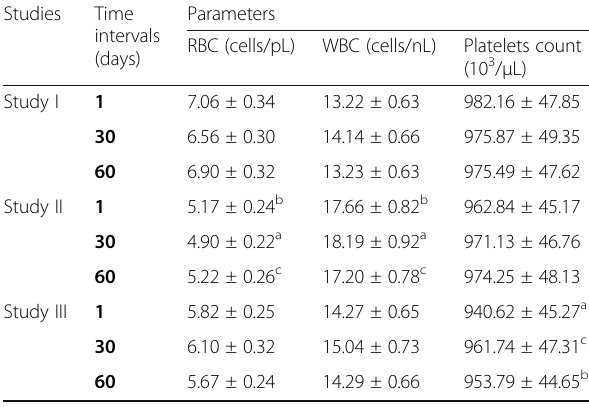
Table 5 Effect of time intervals on hematological parameters of rats in different studies